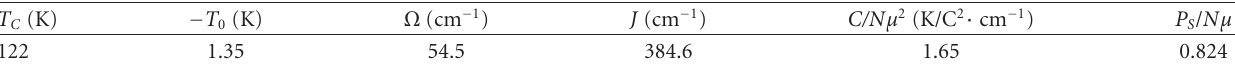
Table 2: Values of the transition temperature T C , the microscopic parameters T 0 and the tunnelling frequency Ω , interaction parameter J (see (4)), the ratio of the Curie temperature C to Nμ 2 (see (7)), and the ratio of the saturated spontaneous polarization P S to Nμ (see (9)) for